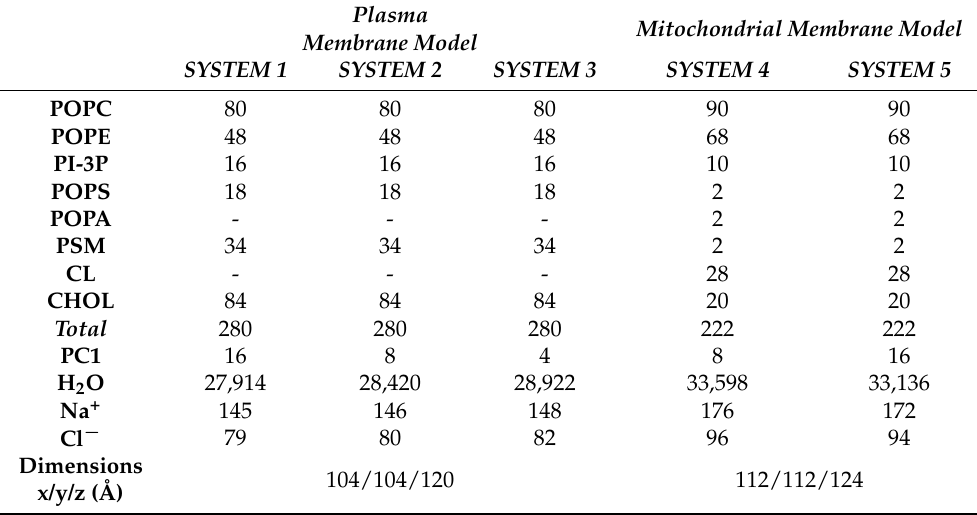
Figure 1. ( A ) Chemical and molecular structures of procyanidin C1, PC1 [(-)-epicatechin –(4 β → 8)- (-)-epicatechin-(4 β → 8)-(-)-epicatechin]. The initial, t = 0 ns, and final, t = 675 ns, systems for ( B ) system 1, ( C ) system 2, ( D ) system 3, ( E ) system 4, and ( F ) system 5. The disposition of the PC1 molecules (numbered) in each one of the systems are also displayed. The PC1 molecules are depicted in licorice representation and the phosphate atoms of the phospholipids, defining the upper and lower boundaries of the membrane, are depicted in VDW representation and an orange colour. The lipid and water molecules and the chloride and sodium ions have been removed for clarity. Table 1. Systems and number of components used in this study. The NaCl concentration was 0.15 M. The production trajectories for each one of the five different systems were calculated for 675